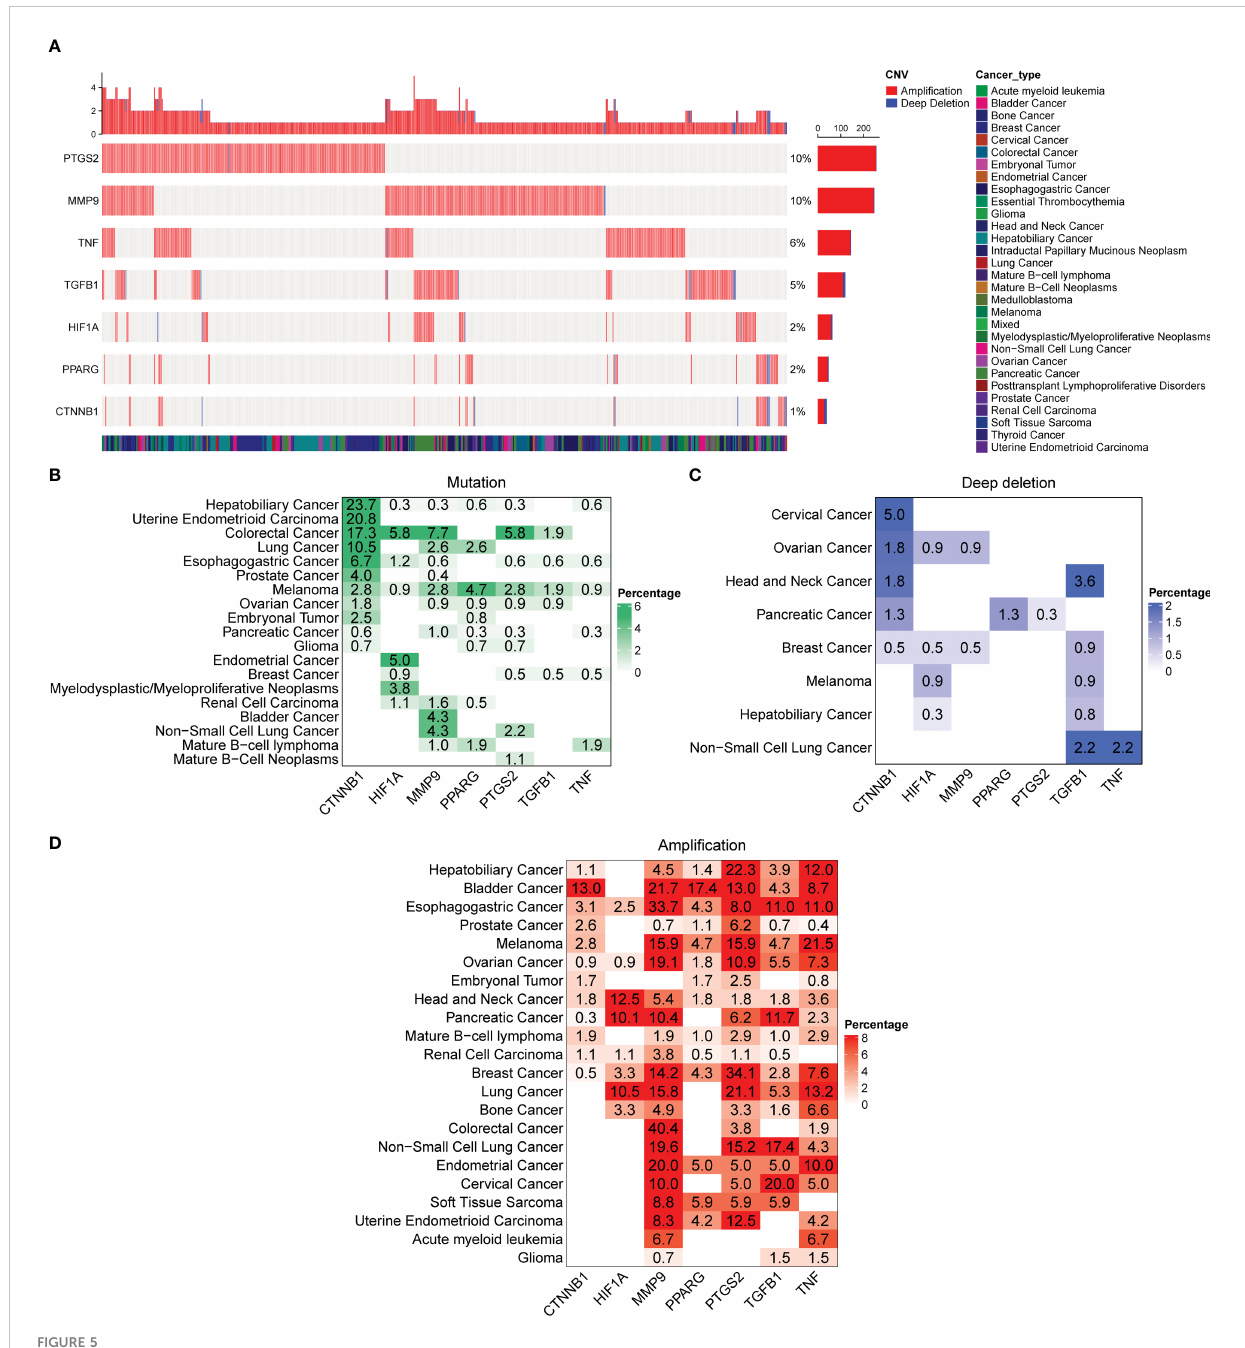
FIGURE 5 Alterations in the DCRGs in cancer based on pan-cancer analysis of whole genomes. (A) Copy number variation (CNV) landscape of DCRGs in various tumors. Each row represents a gene, and each column represents a patient. The CNV frequency of DCRGs is shown. The fi gure only represents patients with DCRG alterations. The mutation rate of each gene is shown in the labels on the right. (B – D) Frequency distribution of mutation (B) , deep deletion (C) , and ampli fi cation (D) in different cancer types. The numbers in the fi gure represent the speci fi c mutation rate, and the color intensity is proportional to the